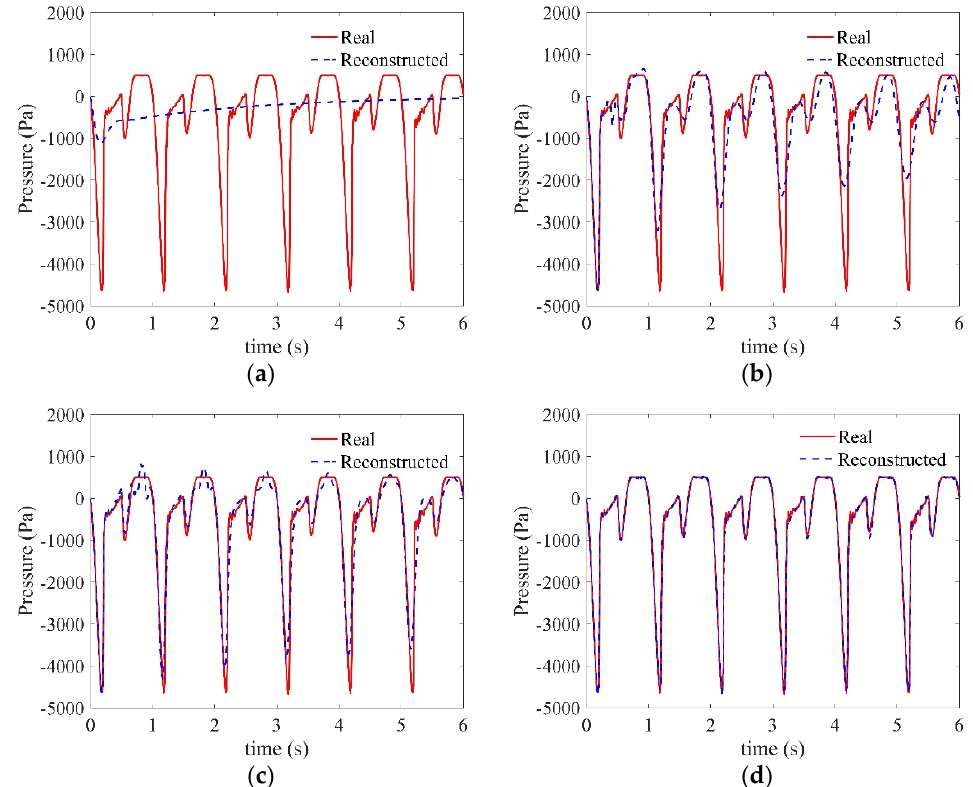
Figure 7. Reconstruction of pressure data measured by sensor #1 (see Table 1) using ( a ) standard DMD and time-delay embedding DMD with number of delay steps ( b ) n d = 50, ( c ) n d = 100, and ( d ) n d = 200.